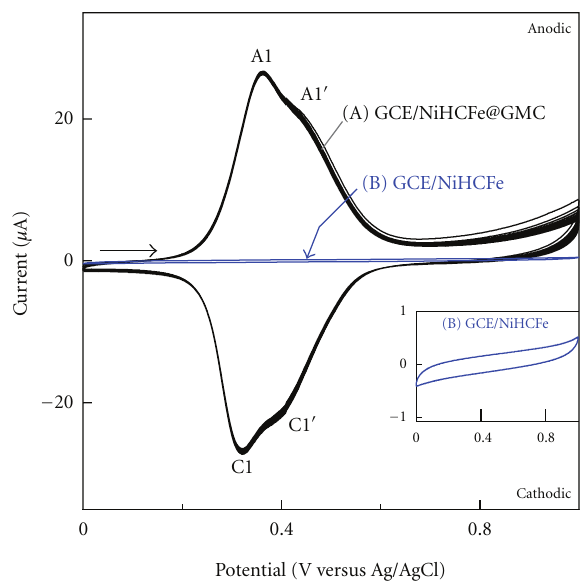
Figure 2: Cyclic voltammograms of GCE/NiHCFe@GMC and GCE/NiHCFe in a pH 7PBS at a scan rate of 50 mVs − 1